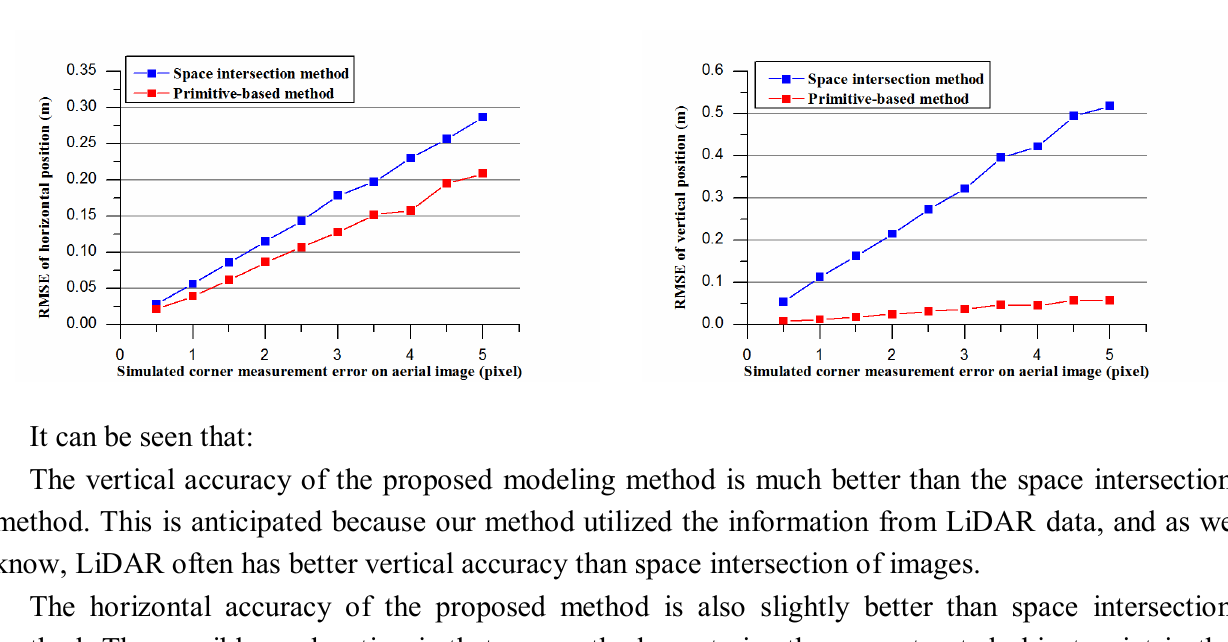
Figure 5. Horizontal error ( Left ) and vertical error ( Right ) of space intersection method and the proposed modeling